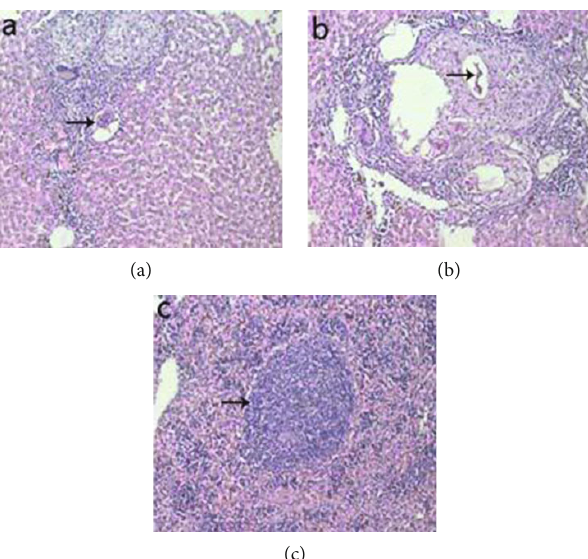
Figure 14: Histological section of infected treated with 400mg/kg Zingiber o ffi cinale group staining with H&E: (a, b) liver showing multiple epithelioid granulomas around deposited bilharzia ova × 200; (c) spleen revealed congested red pulp and hypertrophic red pulp × 200.